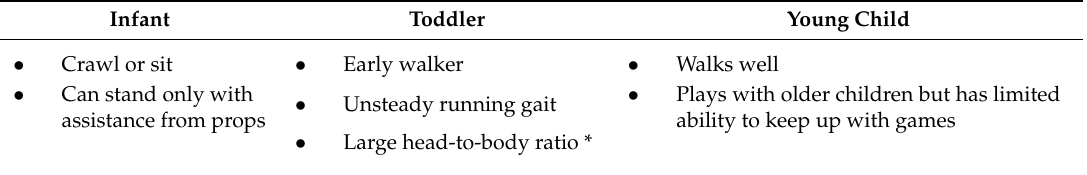
Table 1. Developmental stage characteristics used by observers to classify sub-groups of